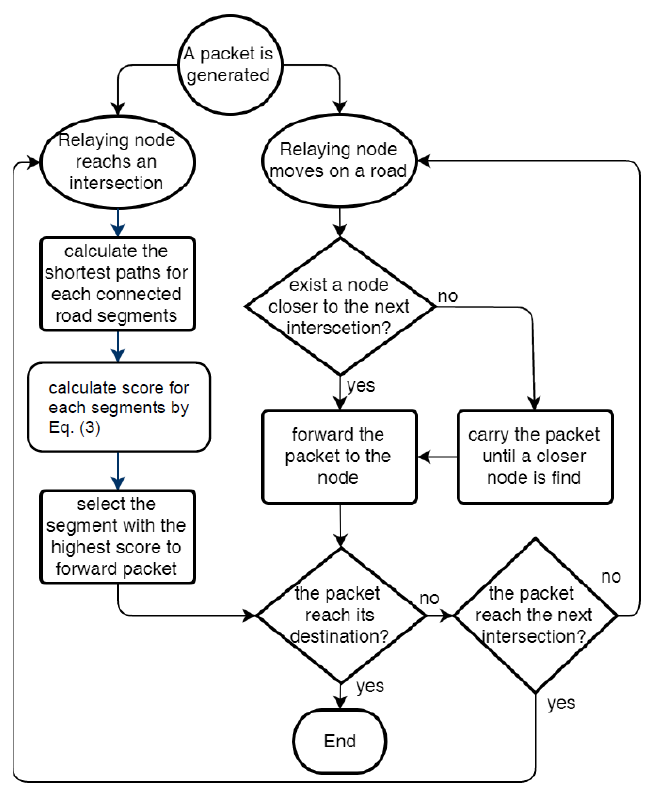
Figure 5. A flowchart of CRT Map Based Routing (CBR).